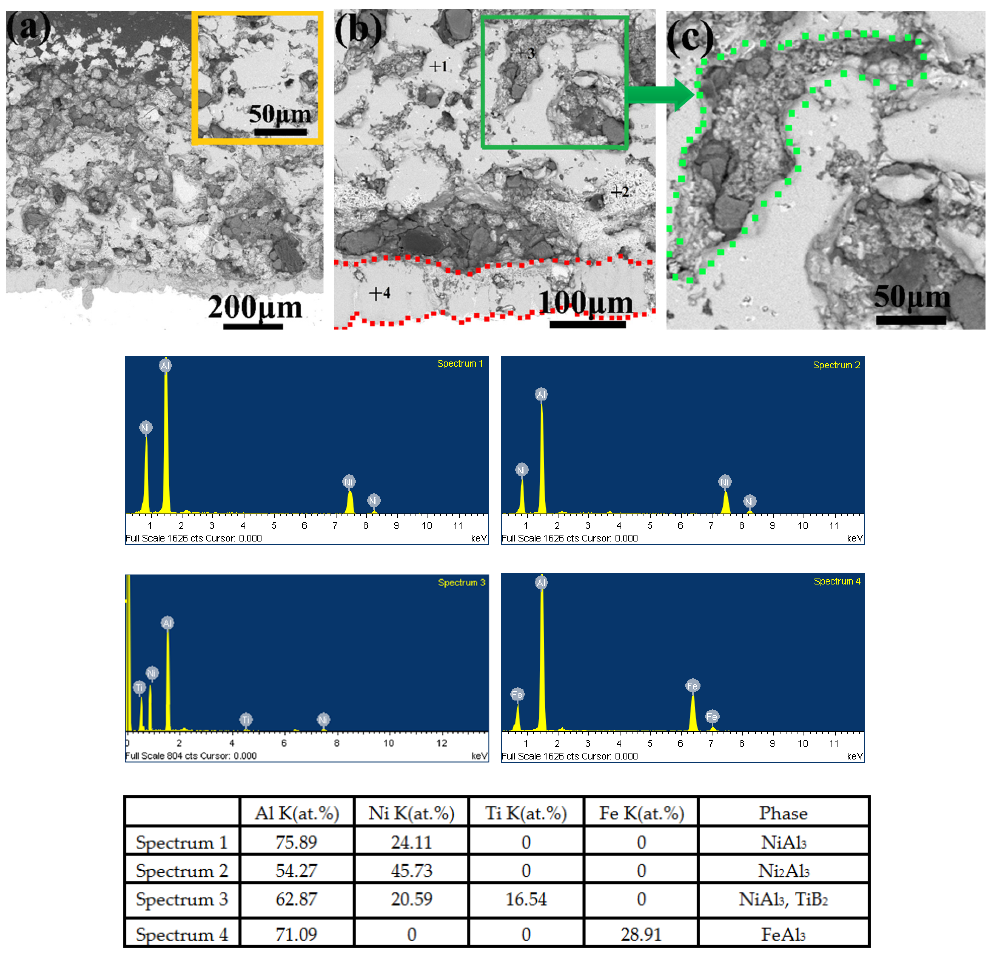
Figure 14. Cross-sectional morphologies and compositions of Ni/Al-TiB 2 coatings as-sprayed at 250 °C and after annealing at 650 °C for 30 h: ( a ) 200×, ( b ) 500×, and ( c ) 1000×.